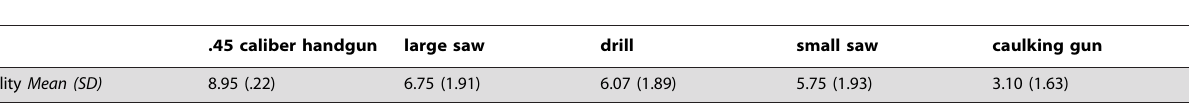
Table 2. Ratings of Object Lethality (Study 2).